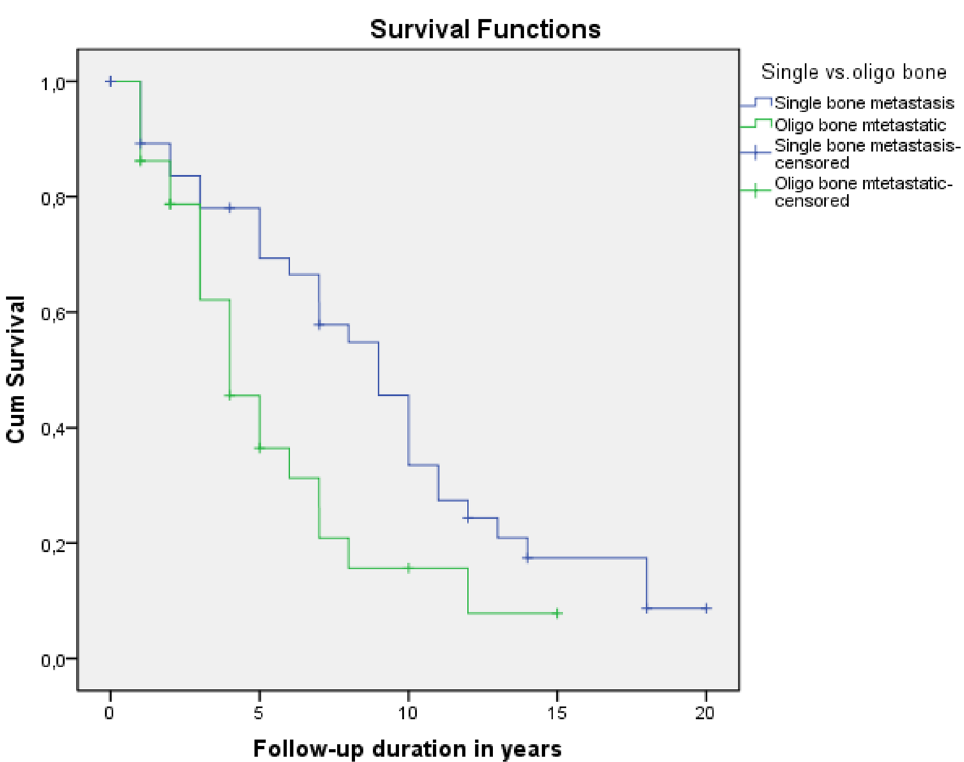
Figure 3. Survival outcomes of patients with SBM and > 1 bone